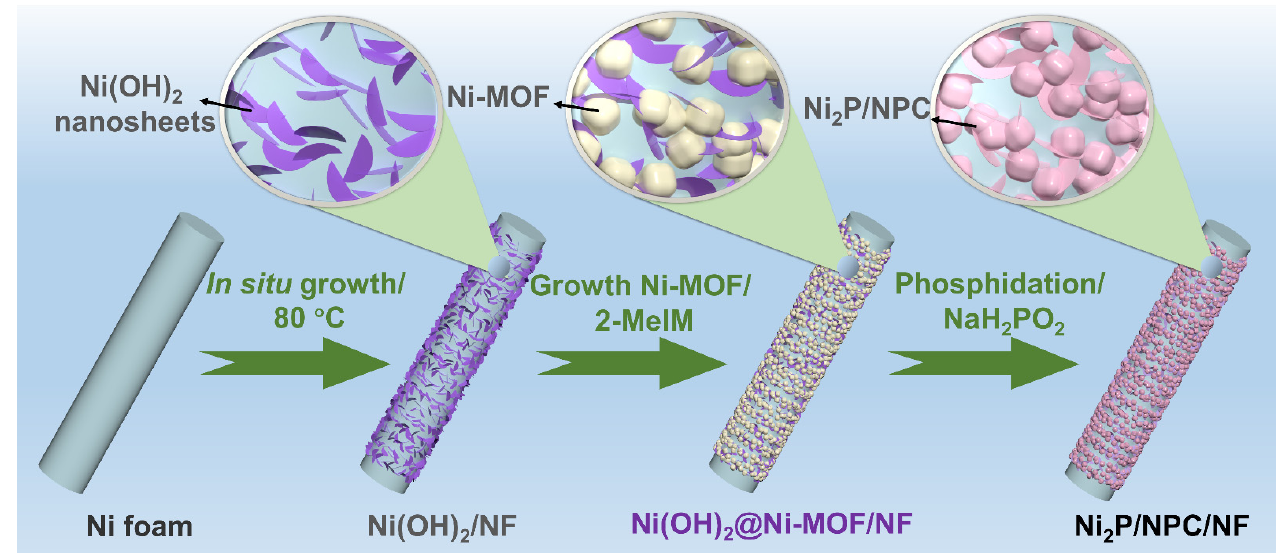
Figure 1. Schematic diagram of the preparation process of Ni 2 P/NPC/NF.